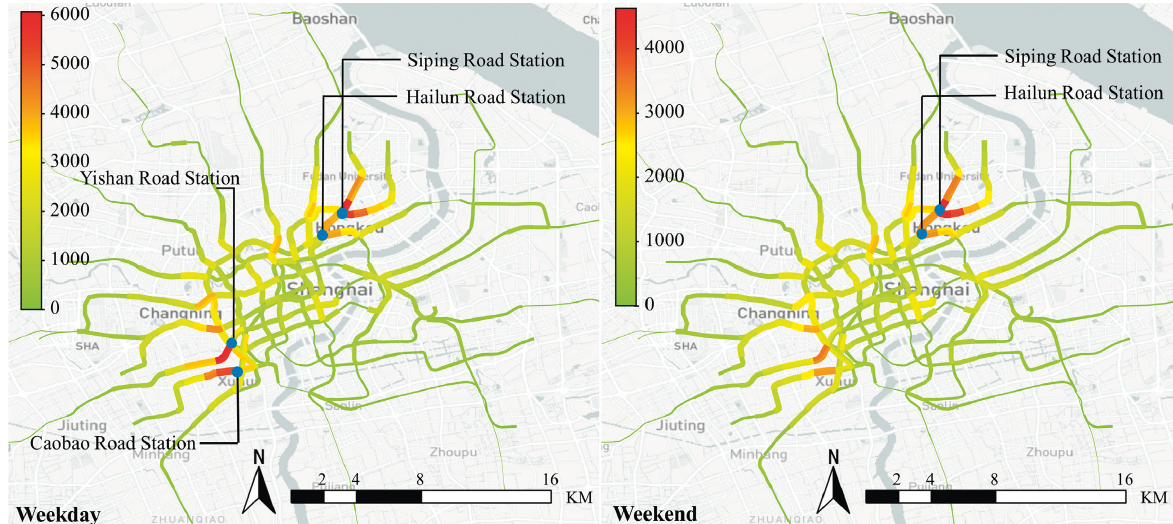
Figure 12: The intensity of competition along the metro